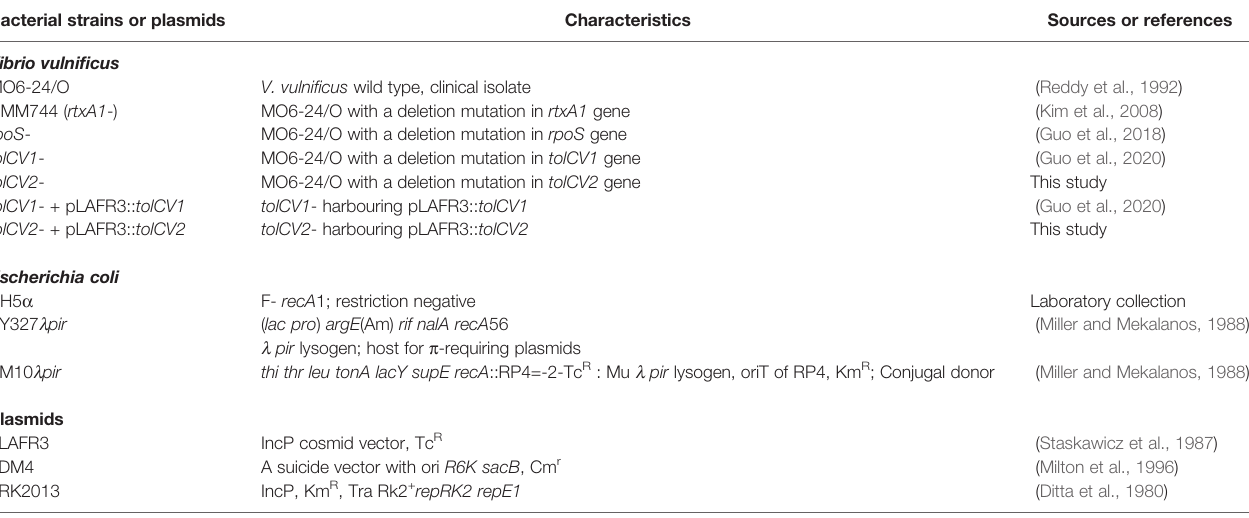
TABLE 1 | Bacterial strains and plasmids used in this